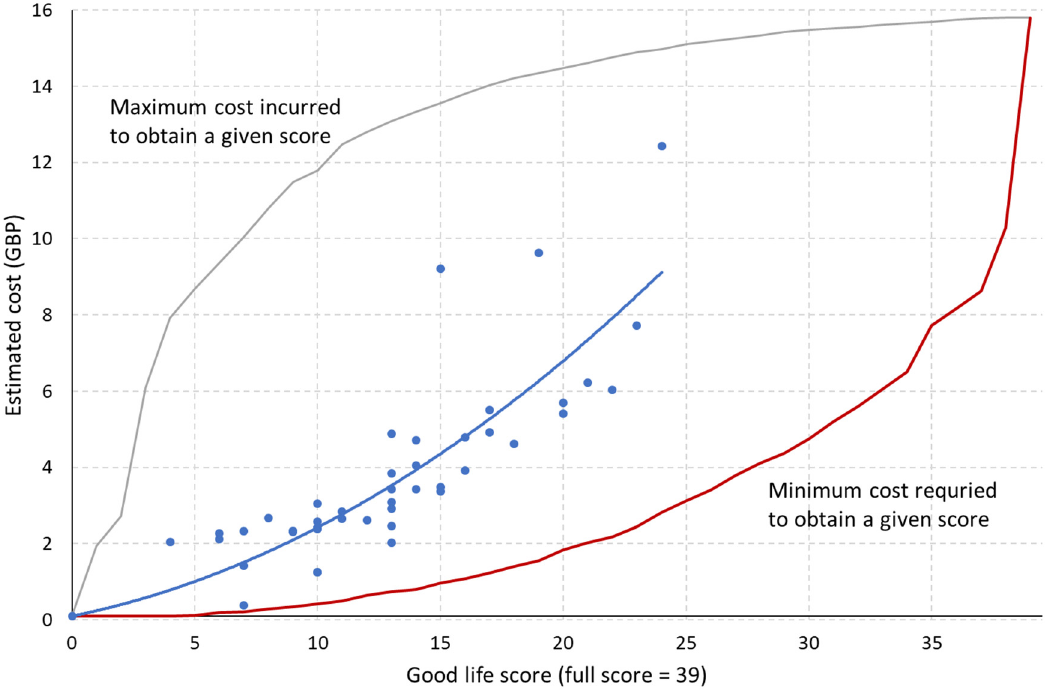
Figure 3. Relationship between resource tier score and estimated cost to achieve them at sample farms ( N = 49). Quadratic trend curve suggests an exponential cost structure (y = 0.01x 2 + 0.13x, R 2 = 0.71), while the discrepancy between observed data (blue) and the minimum cost required to obtain a given score (red) shows the potential to reduce the expenditure without compromising the overall level of positive welfare.